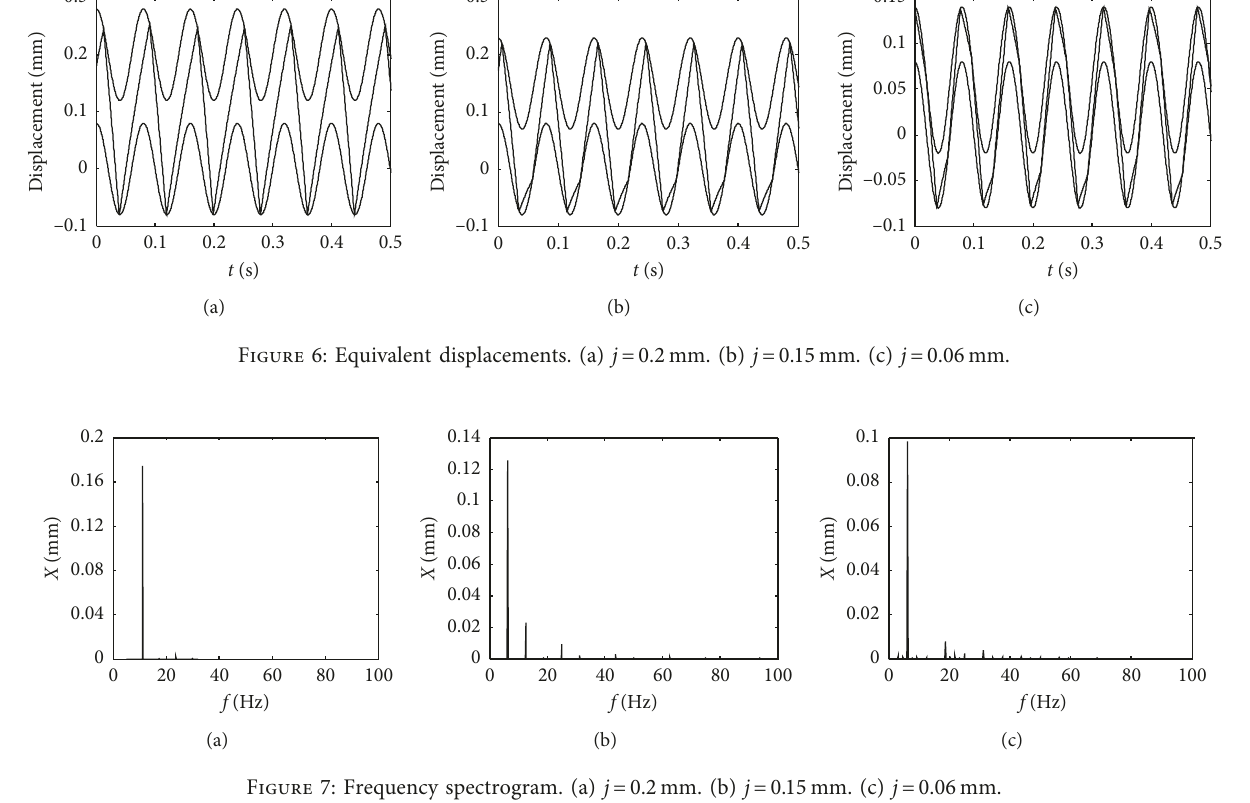
0.15 mm. (c) j (cid:29)